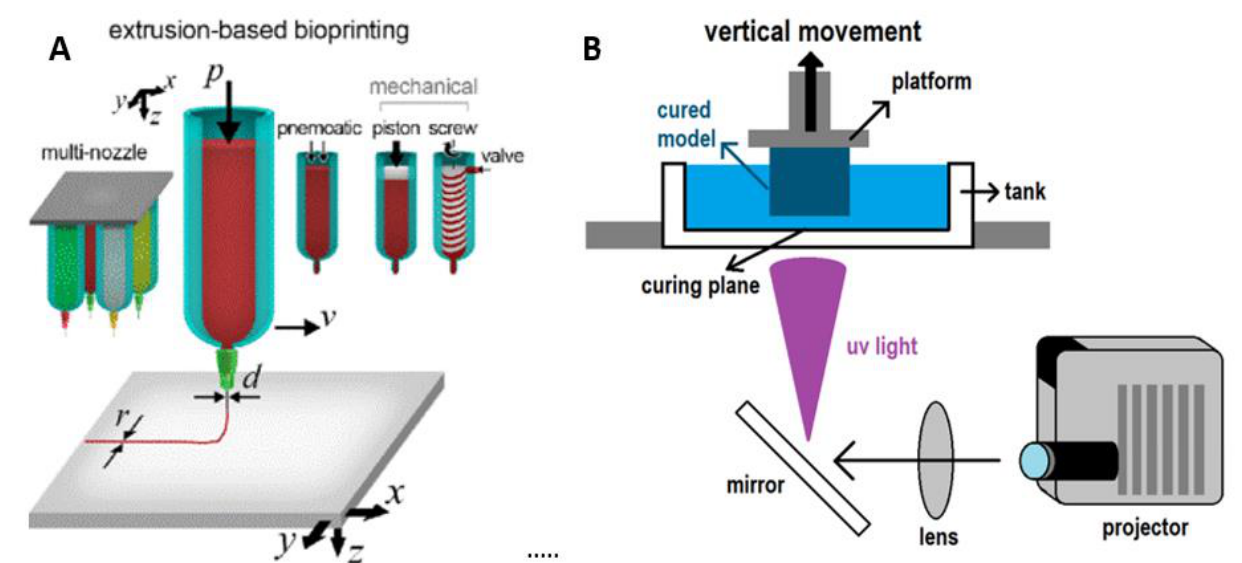
Figure 1. Diagrams showing the working mechanisms of micro-extrusion and DLP printers. ( A ) A micro-extrusion printer with examples of different extrusion nozzles and drivers (mechanical, pneumatic) along with the build platform [20]. ( B ) A DLP printer showing the orientations of the light source, curing plane, fabricated object, and build plate. Reprinted with the permission from Ref. [20]. Copyright 2018 AIP